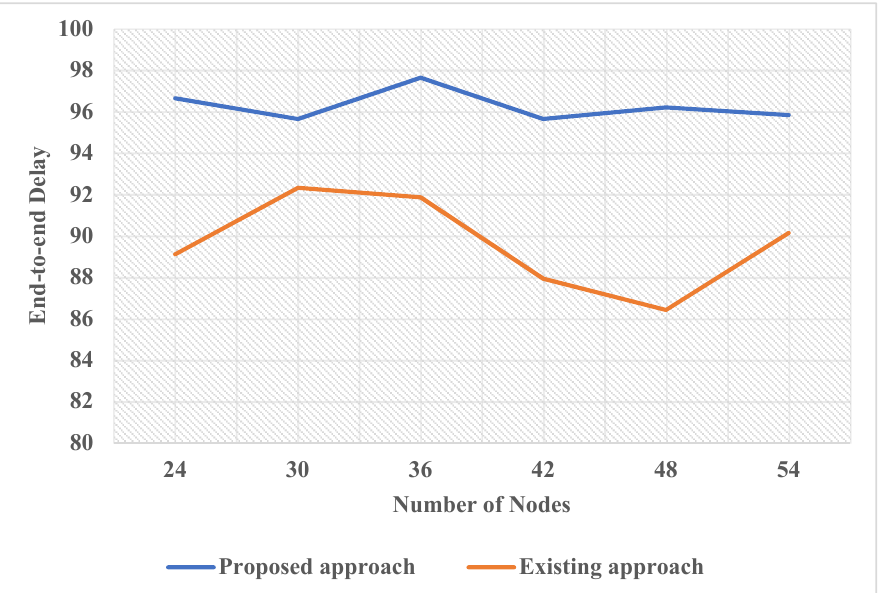
Figure 8. Comparative Analysis in term of End-to-end delay, number of nodes utilization of energy consumption.